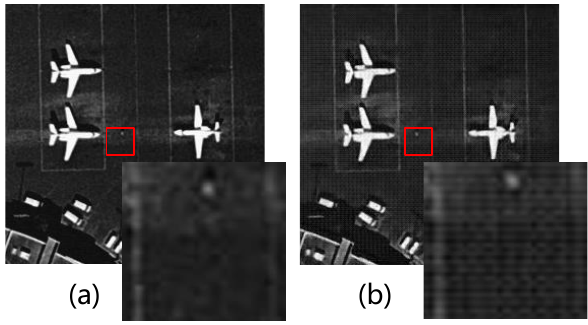
Figure 4. Diagram of checkerboard artifacts. ( a ) original image without noise; ( b ) despeckling image with checkerboard artifacts caused by transposed convolution.